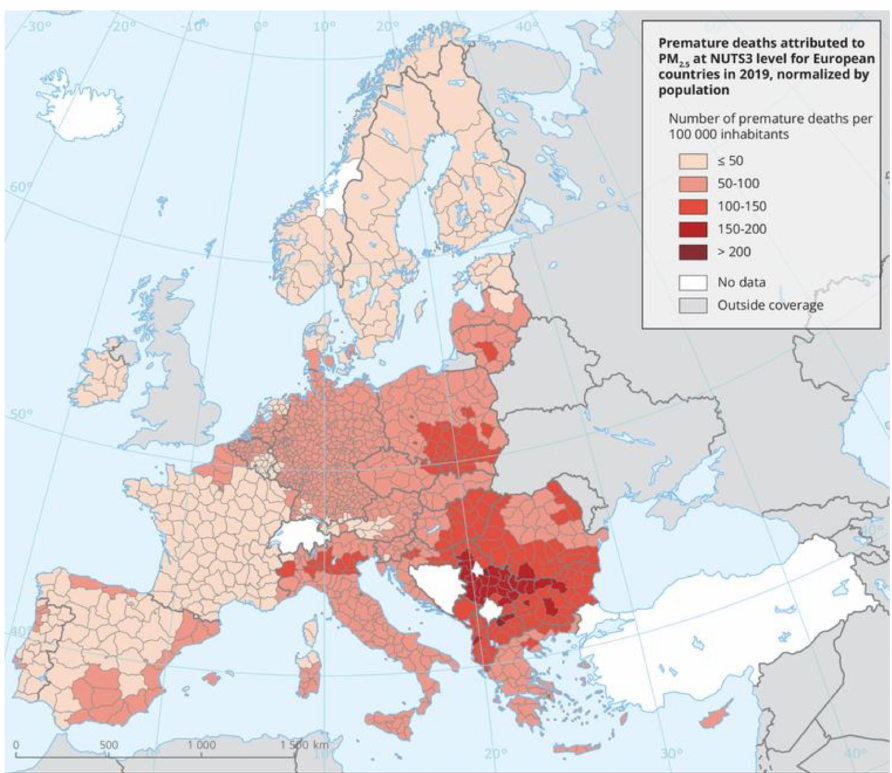
Figure 1. Premature deaths attributed to PM 2.5 for European countries in 2019, normalized by population (source: European Environmental